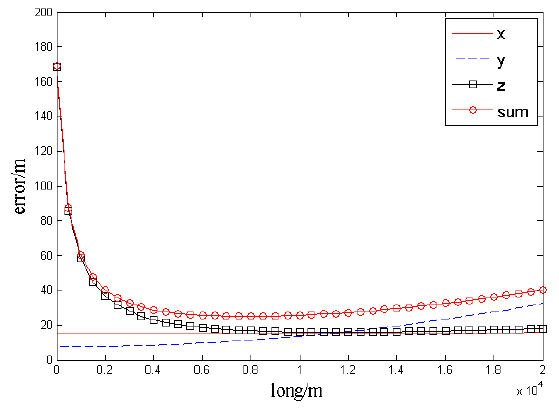
Figure 8. Error curves.